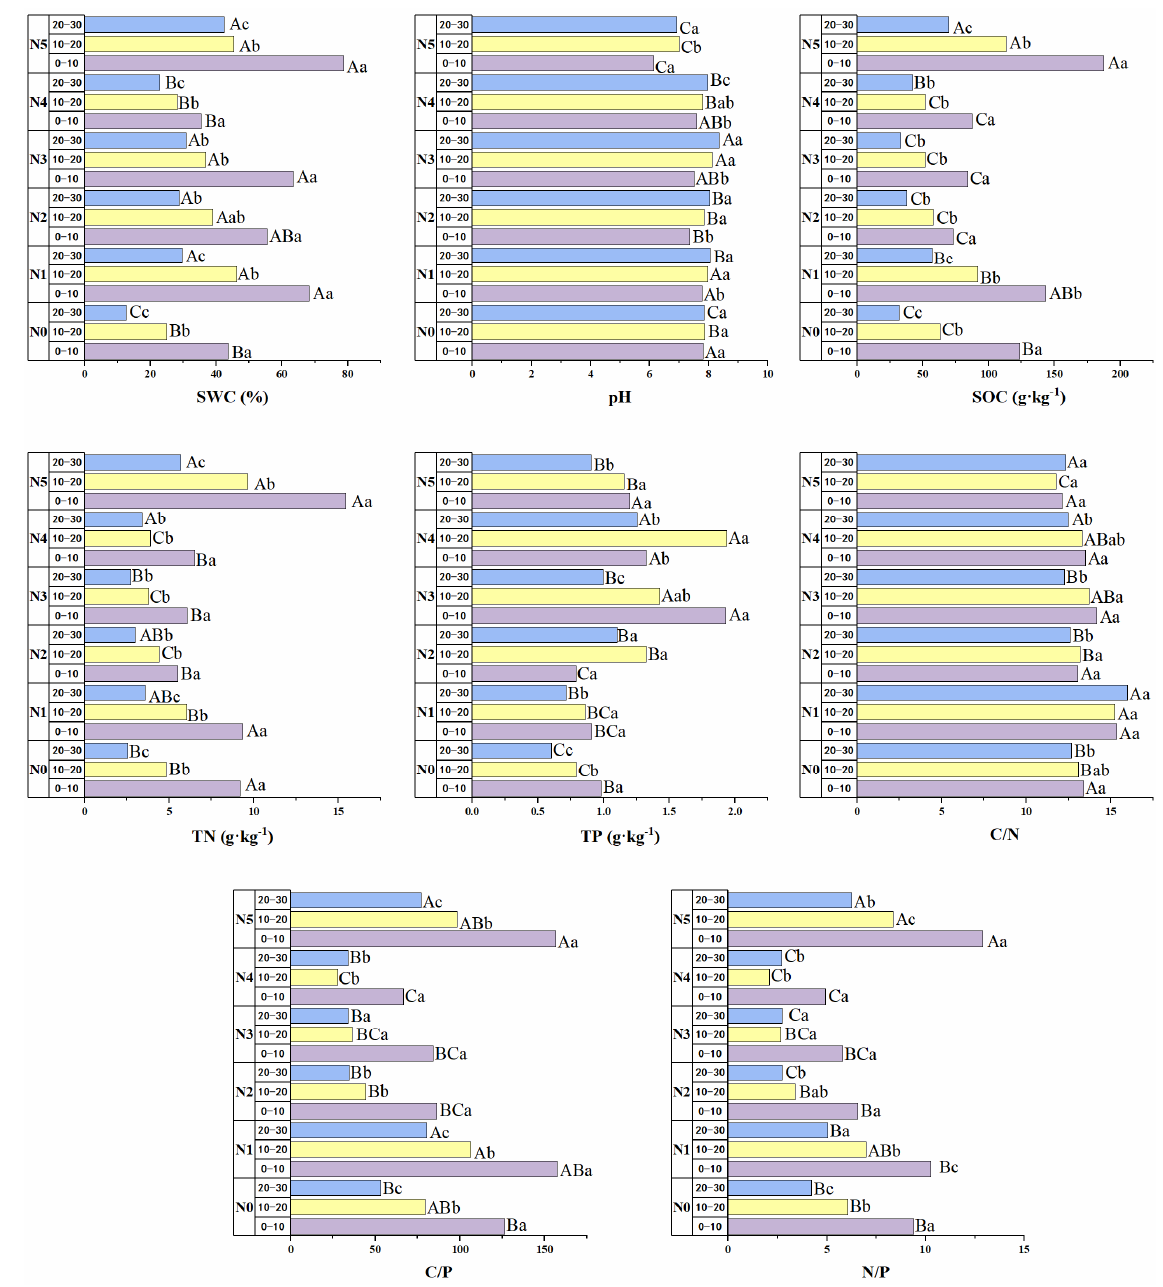
Figure 4. One-way ANOVA of soil ecological stoichiometry and biomass characteristics of Picea schrenkiana in different soil layers under different nitrogen source input levels in the Tianshan Mountains, Xinjiang. FLR is first-order fine roots; SLR is second-order fine roots; and TLR is third-order fine roots. Different capital letters represent significant differences in the ecological stoichiometry of elements in the same root order under different nitrogen sources ( p < 0.05); different lower case letters represent significant differences in the ecological stoichiometry of elements in different root orders under the same nitrogen sources ( p < 0.05).